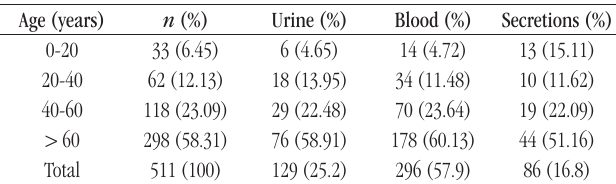
taBLE 1 − Epidemiological profile of patients